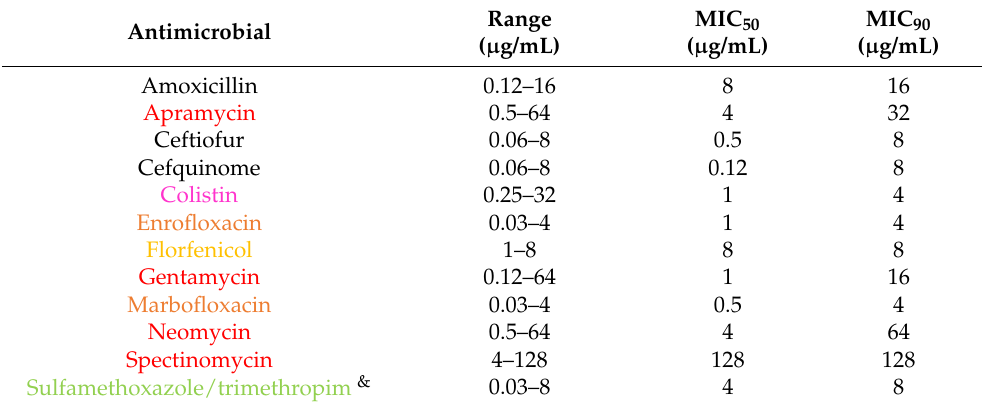
Table 3. Escherichia coli MIC range, MIC 50 and MIC 90 for 1571 strains isolated from digestive clinical cases. The same color in the antimicrobial column represents member of the same antimicrobial family.